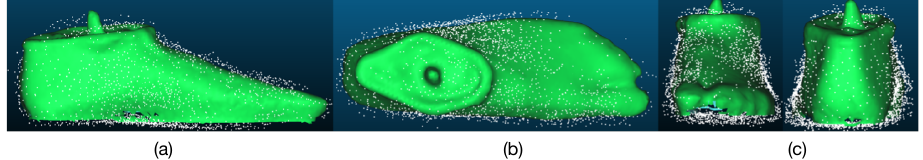
Figure 8. Comparison between optical imaging (green image) and scan data (point cloud). Sideview ( a ), top view ( b ), and front and back view ( c ). The two techniques agree within 3 mm in general with some outliers still selected as valid data.